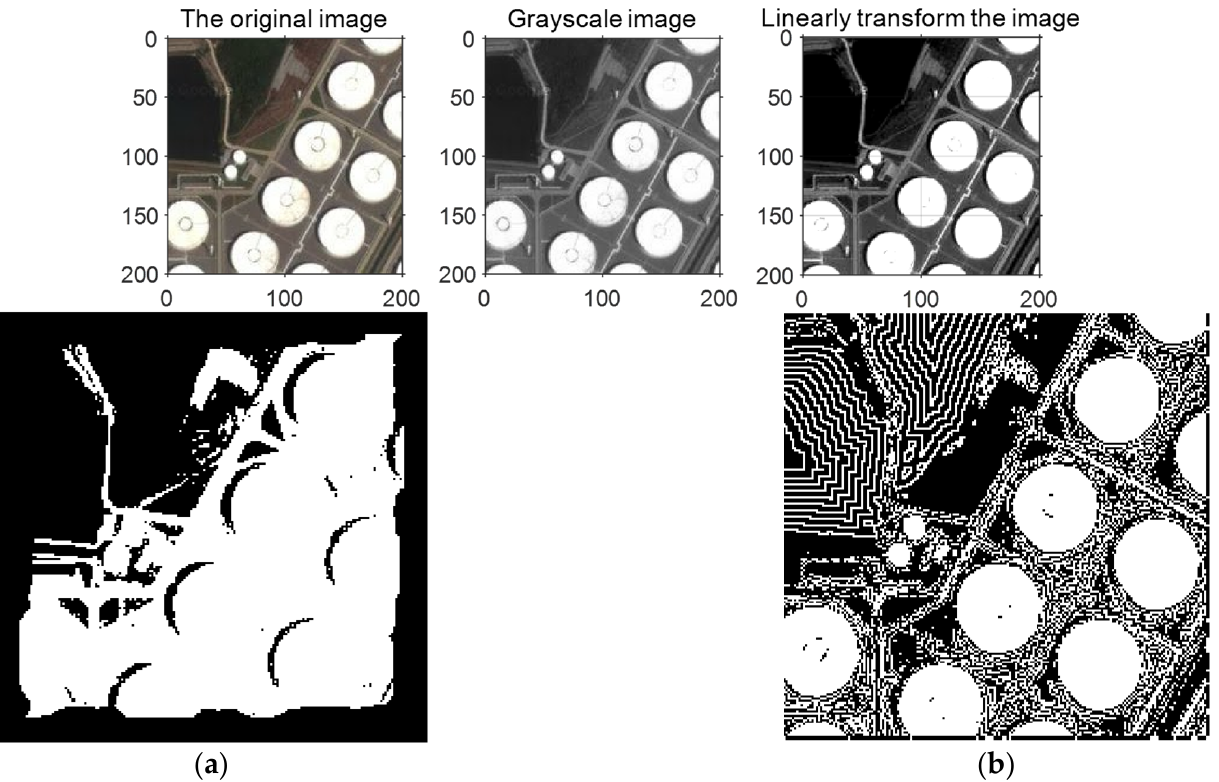
Figure 7. Comparison of image segmentation effects before and after preprocessing: ( a ) before image preprocessing; ( b ) after image preprocessing.